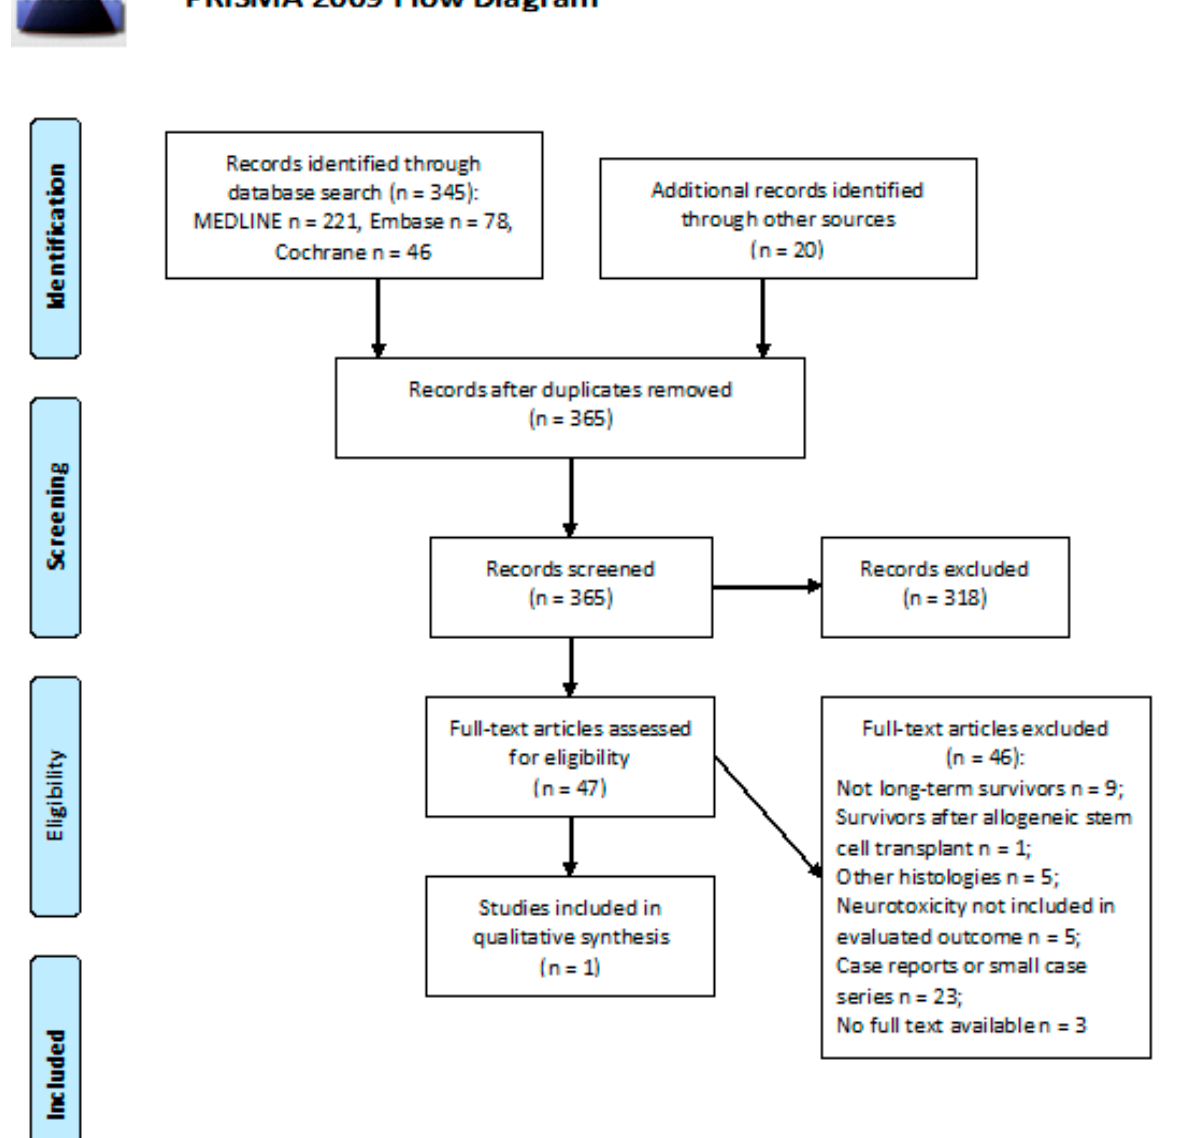
Figure 1. PRISMA flow diagram on peripheral neuropathy.